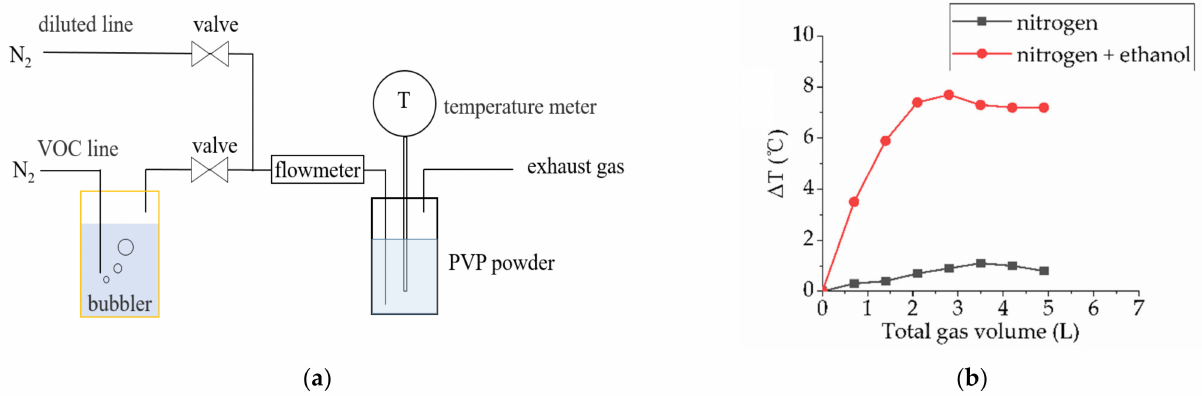
Figure 10. ( a ) The ethanol vapor was injected into the container with 10 g PVP powders. ( b ) The temperature difference ( ∆ T) of PVP powders was tested with a